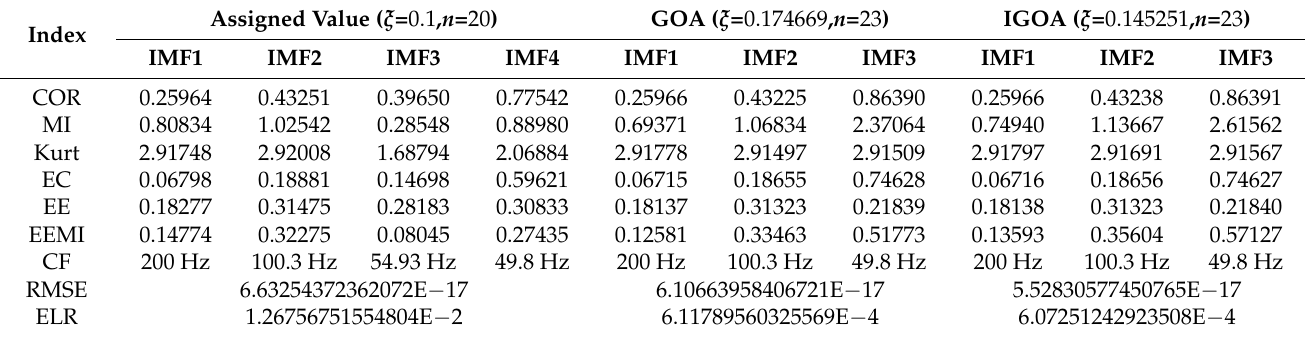
Table 6. Decomposition results evaluation of simulated signal x(t) under different parameters.